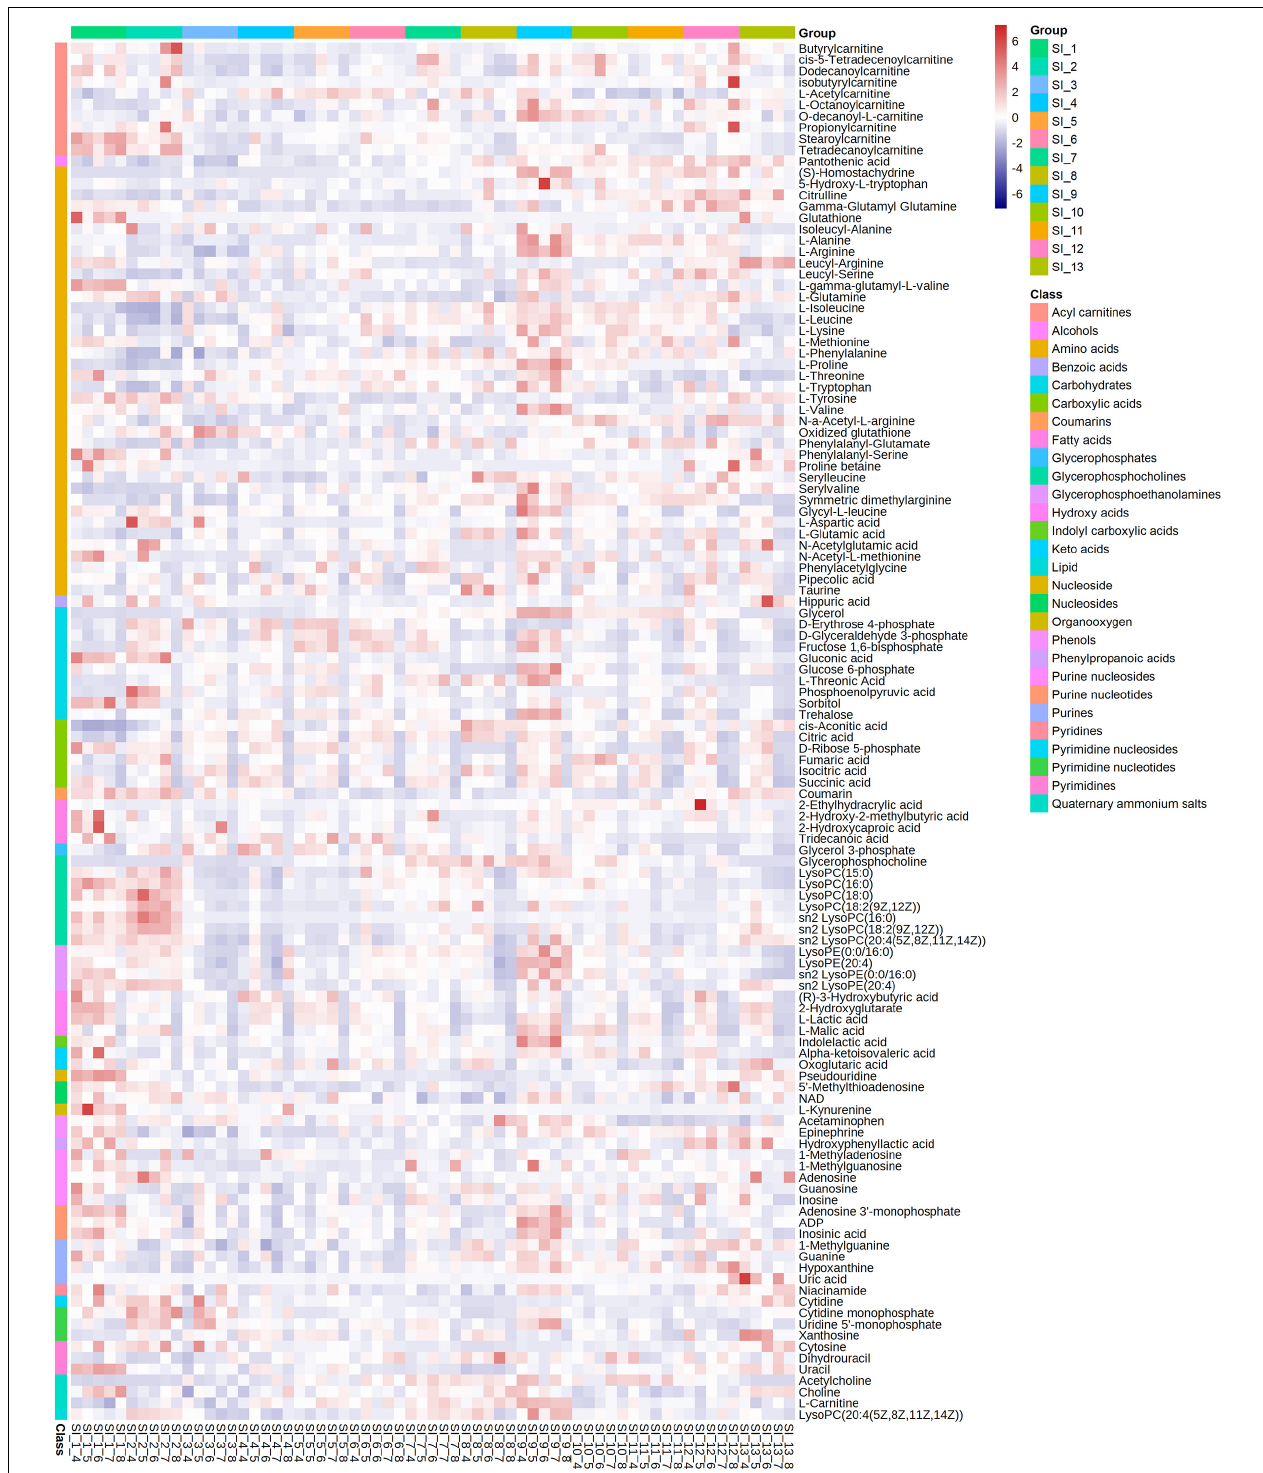
FIGURE 6 | Correlation analysis of all identified differential metabolites from SI_1 ∼ SI_13 to draw a heat map. 122 metabolites are divided into 28 clusters. The significance level is p < 0.05.